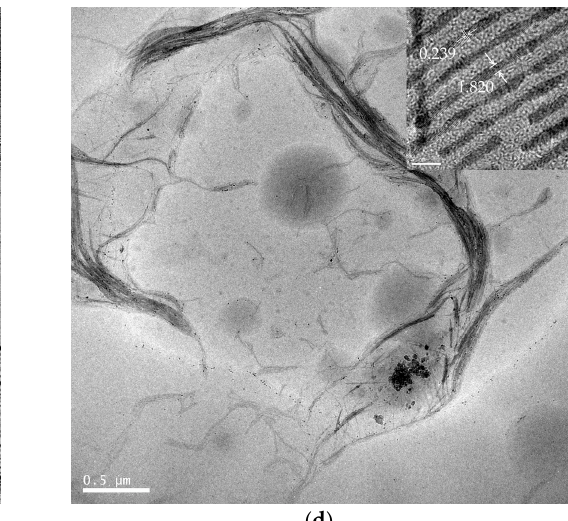
Figure 2. X-ray diffraction (XRD) pattern of silk-like ultralong and ultrathin nanowires.